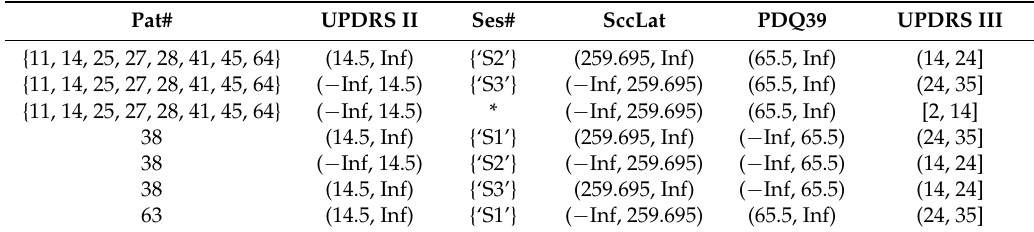
Table 11. Fragment of decision table for UPDRS III